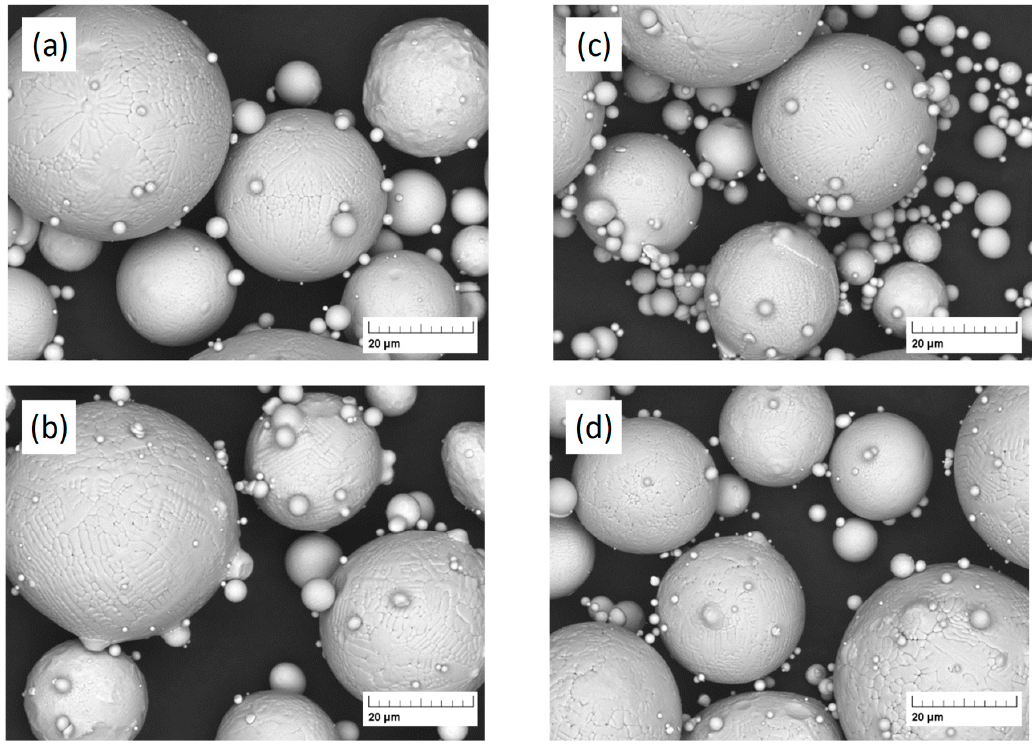
Figure 7. SEM images of gas-atomized powder (particle size 20–63 µ m): ( a ) 316L-Low Ni-1 Ar / Ar (Run 3), ( b ) 316L-Low Ni-1 N 2 / N 2 (Run 4), ( c ) 316L-Low Ni-2 Ar / Ar (Run 5), and ( d ) 316L-Low Ni-2 N 2 / N 2 (Run 6).